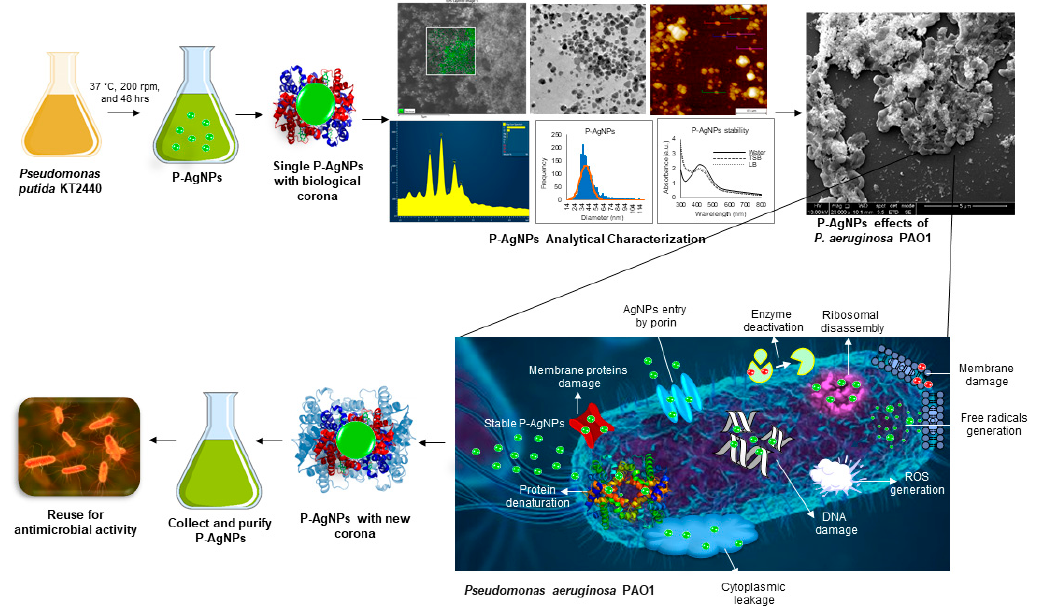
Figure 1. Schematic presentation of P-AgNPs formation from P. putida and their antimicrobial activity against P. aeruginosa with different mechanisms of action (such as membrane leakage, DNA damage, free radicals generation, reactive oxygen species generation (ROS), protein denaturation, ribosomal disassembly etc.). The figure also describe the hypothesis of corona layer addition and enhancement in antimicrobial activity of nanoparticles, if the host and target organism are closely related.